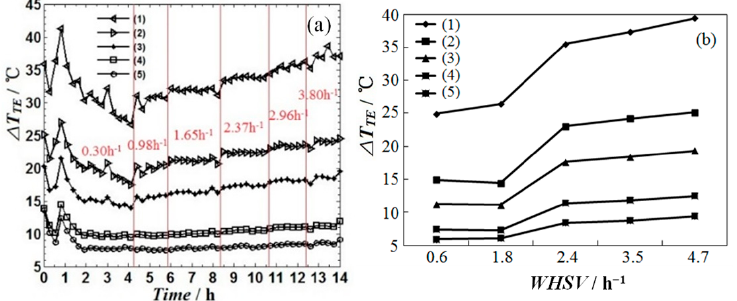
Figure 5. Variation in temperature difference of the thermoelectric modules with time ( a ) and space velocity ( b ).